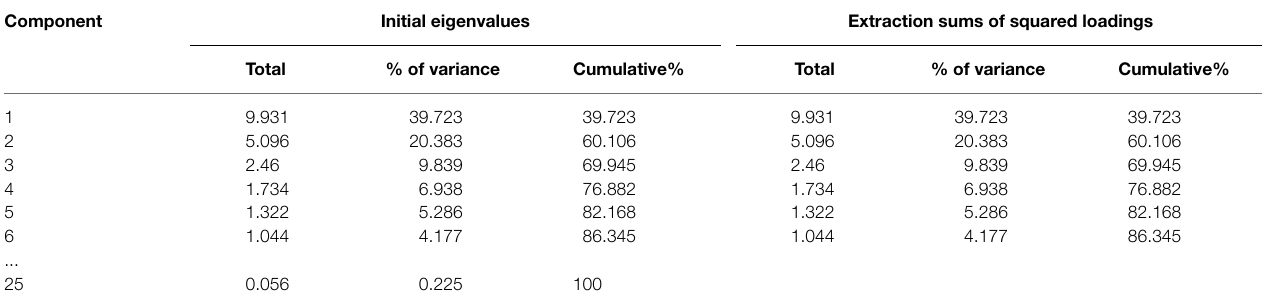
TABLE 4 | Total variance